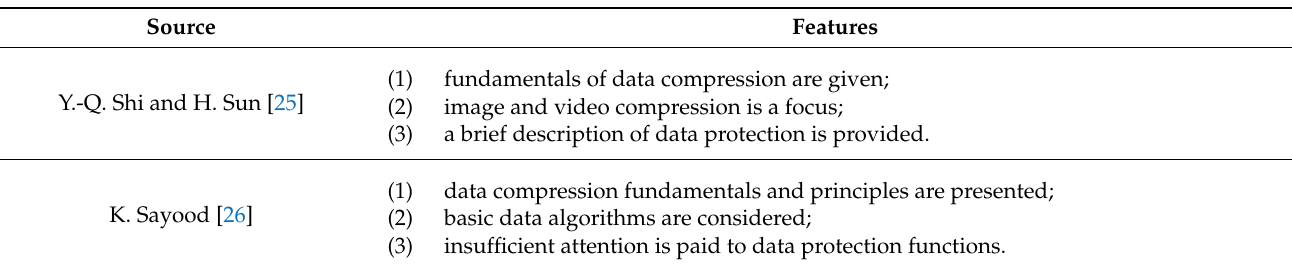
Table 1. Summary of the related